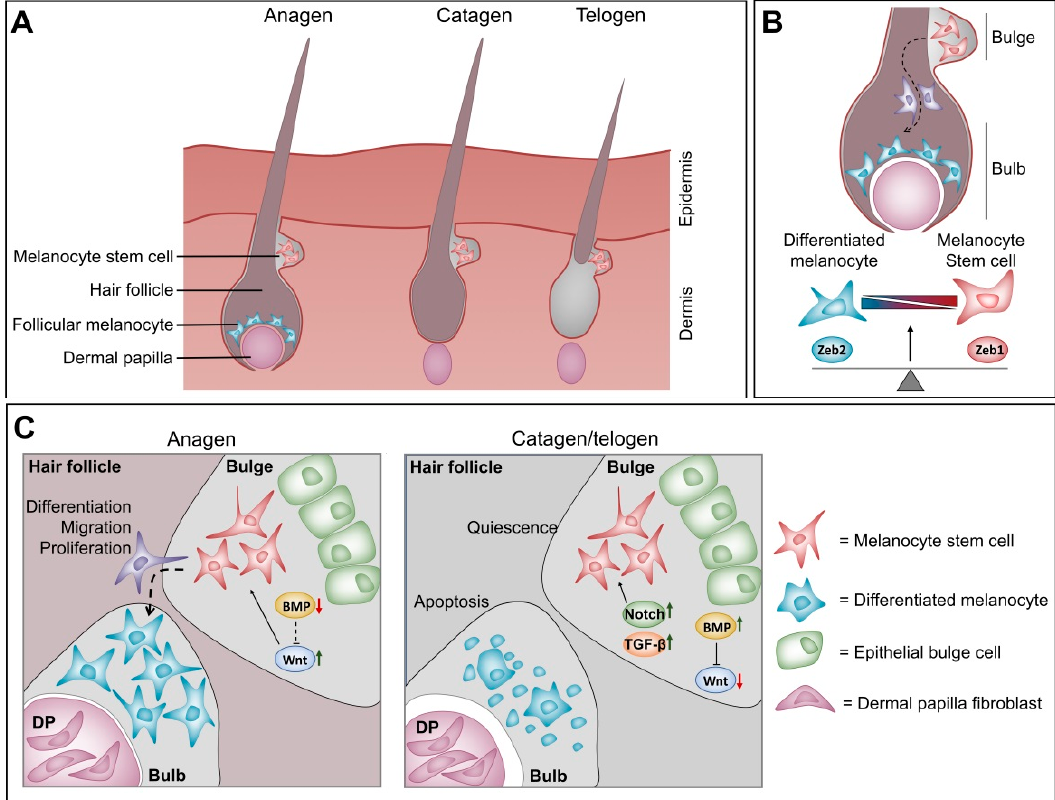
Figure 2. The intrinsic balance between ZEB1 and ZEB2 plays a role in melanocyte homeostasis during the hair cycle ( A ) Schematic representation of the hair cycle. Di ff erentiated follicular melanocytes are only present during anagen phase while melanocyte stem cells are retained throughout the di ff erent phases of the hair cycle. ( B ) Strong ZEB1 expression is associated with a quiescent melanocyte stem cell state in the bulge area of the hair follicle (red coloured cells). Strong ZEB2 expression drives melanocyte di ff erentiation and well-di ff erentiated melanocytes are typically present in the bulb area of the hair follicle (blue coloured cells). ( C ) A balance between di ff erent micro-environmental signalling cues modulates melanocyte homeostasis during the hair cycle. These signalling cues hypothetically function by influencing the ZEB expression balance in melanocytes.